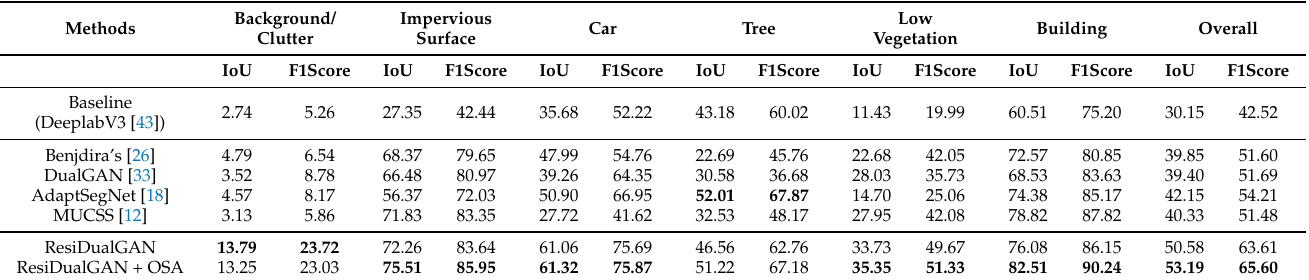
The bold number is the best result of every column.